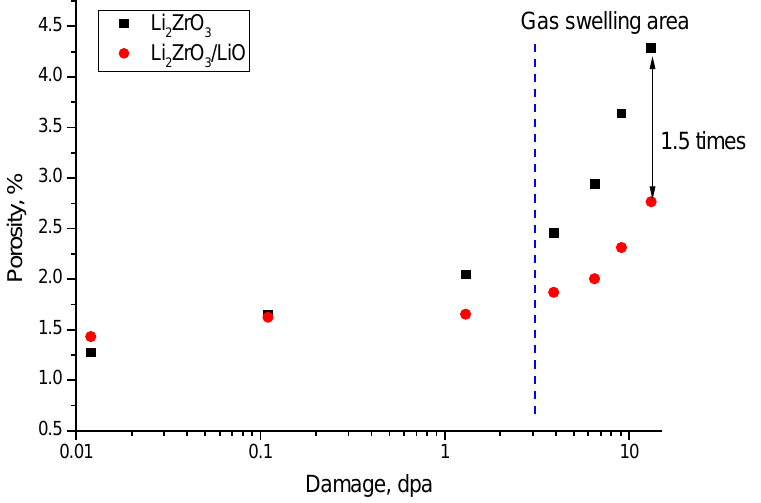
Figure 4. Results of changes in the porosity of ceramics depending on irradiation dose.